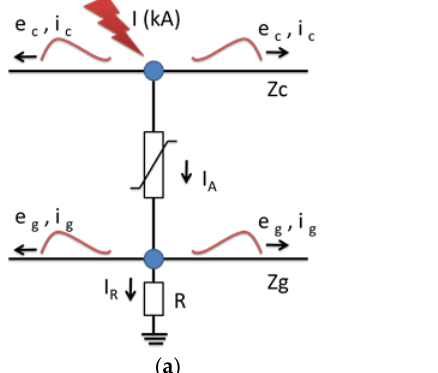
(C) Arrester energy discharge at different overhead ground wire distances